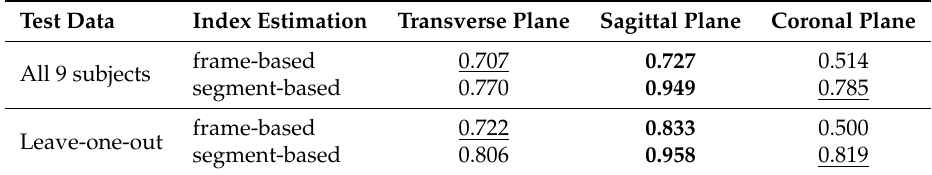
Table 2. AUCs obtained from experiments considering only the lower body. The first and second highest results are emphasized in bold and underlined, respectively.